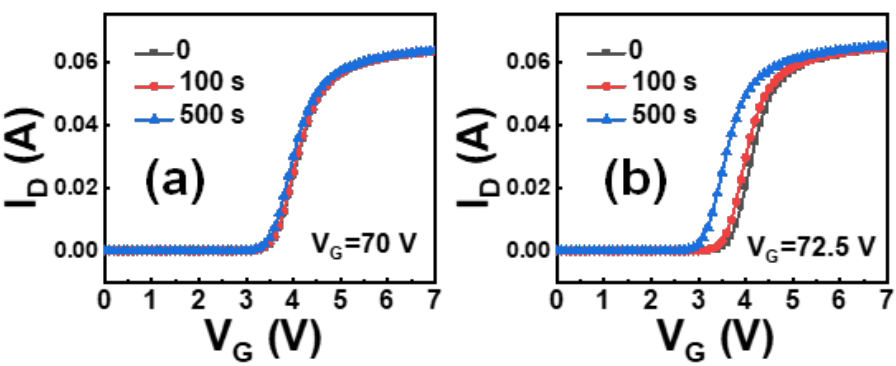
Figure 4. I D -V G curves measured after stress time of 0 s, 100 s, and 500 s with ( a ) V G = 70 V and ( b ) V G = 72.5 V.